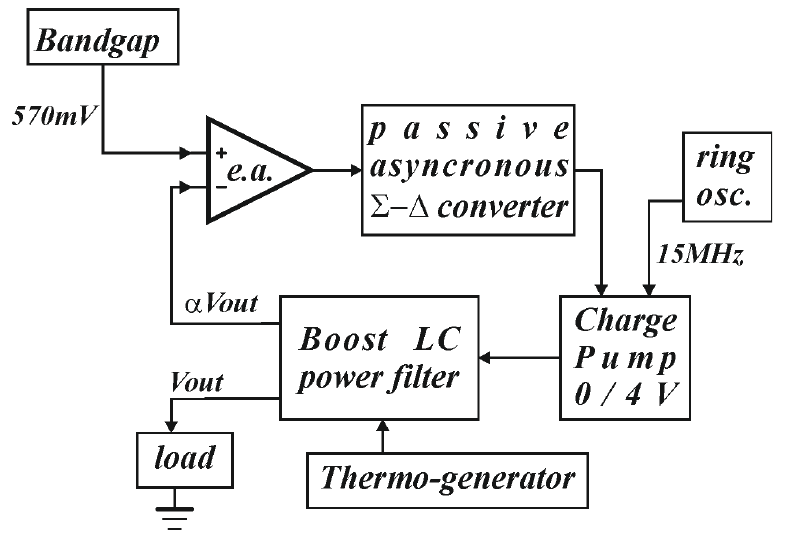
Figure 10. The hybrid converter presented in